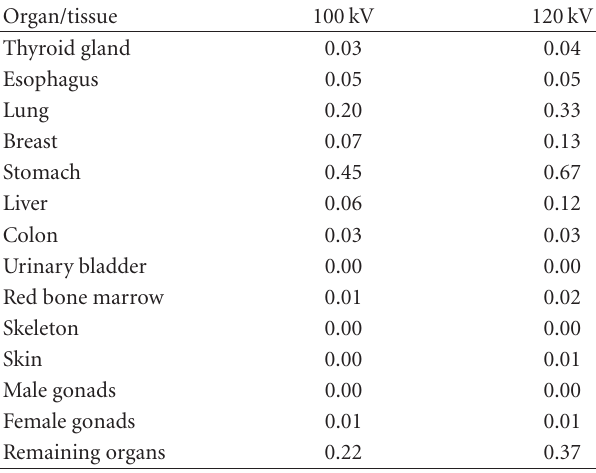
Table 2: Measured organ equivalent doses of high-pitch CTCA using di ff erent tube voltages